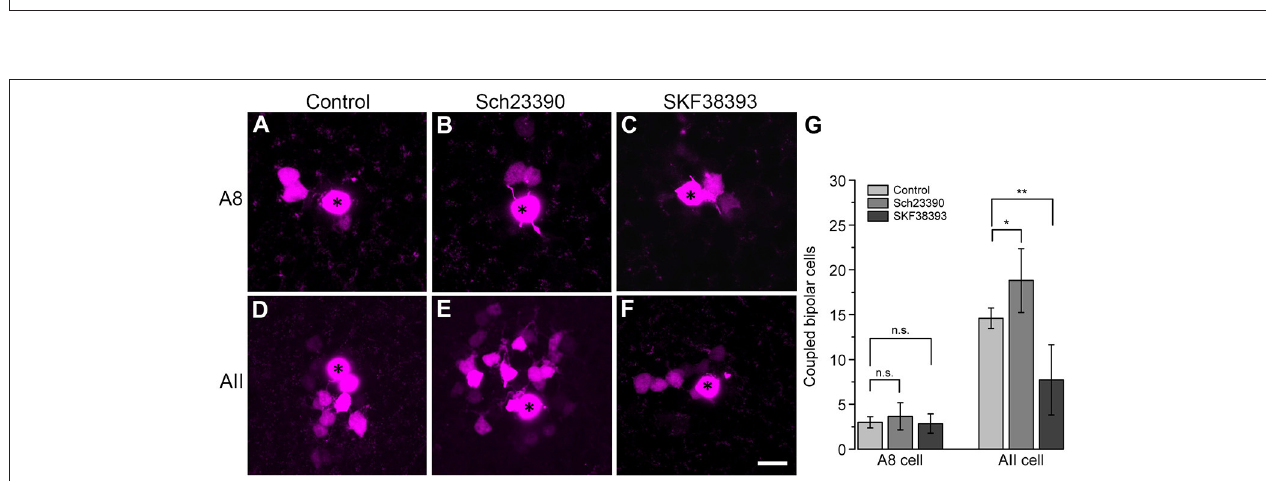
FIGURE 8 | Coupling of A8 amacrine cells did not change in the presence of the D 1 receptor antagonist Sch23390 or the D 1 receptor agonist SKF38393. (A,C) Maximum projection of A8 (A–C) and AII amacrine cell coupling (D–F) to bipolar cells in control condition (A,D) and upon application of Sch23390 (B,E) or SKF38393 (C,F) . Asterisks denote the injected cells. Scale bar: (A–F) , 10 µ m. (G) Bar graph depicting the number of bipolar cells coupled to AII and A8 cells. In AII but not A8 amacrine cells, coupling was significantly increased in the presence of the D 1 receptor antagonist (Wilcoxon rank sum test, AII cells: * p = 0.0159, N = 5; A8 cells: p = 0.5455, N = 6) and significantly decreased in the presence of the D 1 receptor agonist (Wilcoxon rank sum test, AII cells: ** p = 0.0089, N = 7 from 5 mice; A8 cells: p = 0.99, N = 7 from 5 mice).